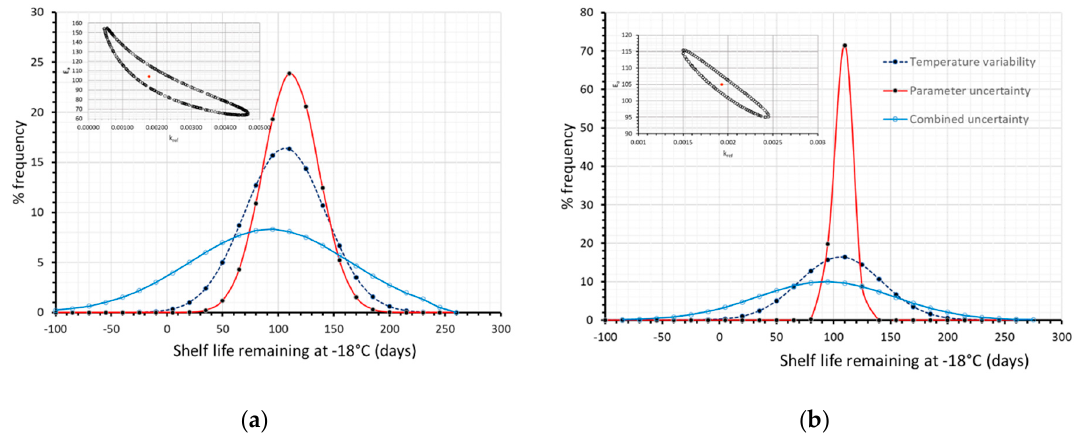
Figure 7. Remaining shelf life of frozen green peas, after 130 days in the cold chain, when only temperature variability (dashed blue line), only parameter uncertainty (red line) or both temperature variability and parameter uncertainty (solid light blue line) were incorporated within model’s prediction algorithm. ( a ) when assuming broader 95% C.I. ( b ) when assuming narrower 95% C.I. Relative Joint Confidence Regions are depicted within plots.